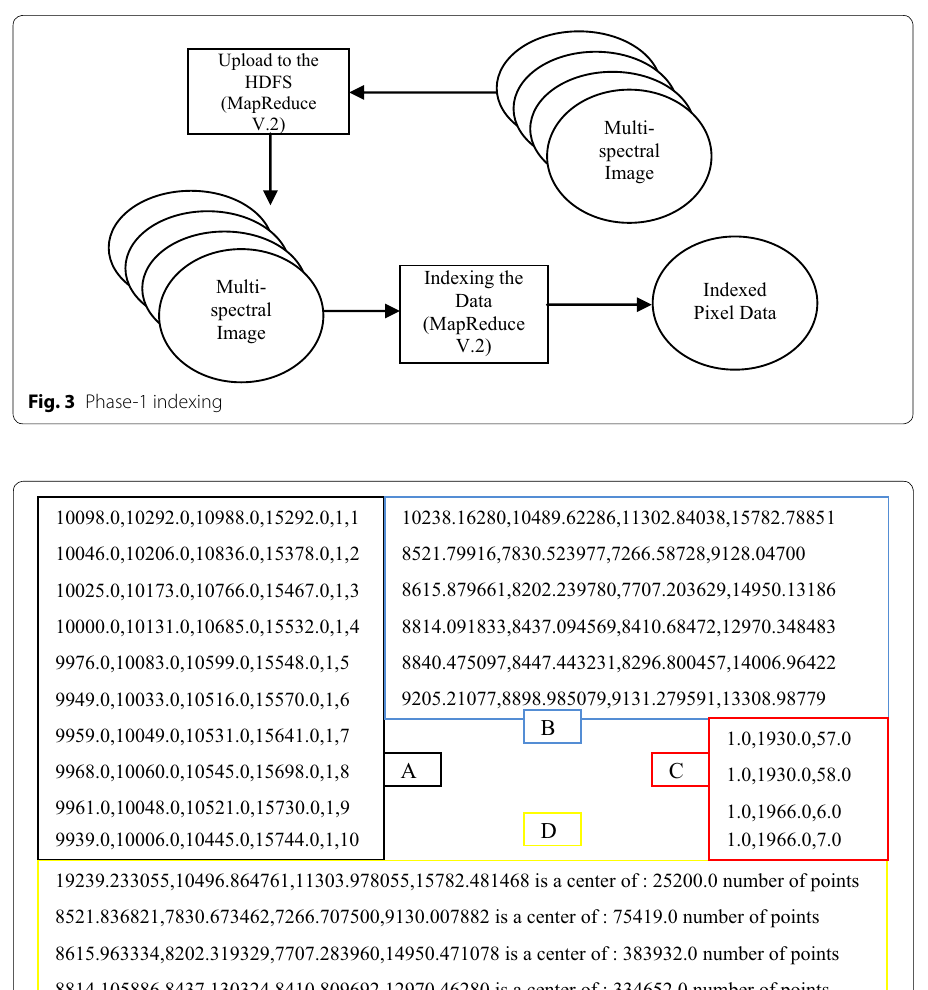
Fig. 4 The image after the preparation ( a , c ) and after being clustered ( b , d